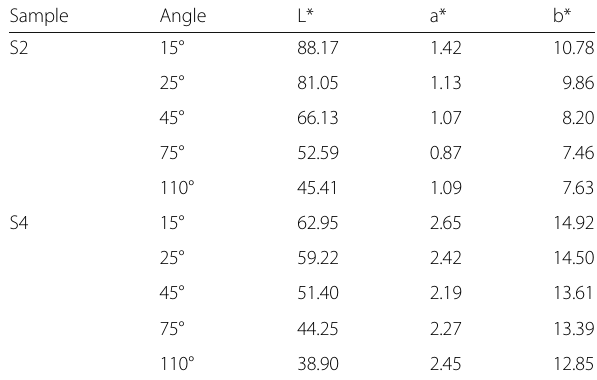
Table 2 The CIE L*a*b* values of Al/MnO 2 composite pigments (S2,